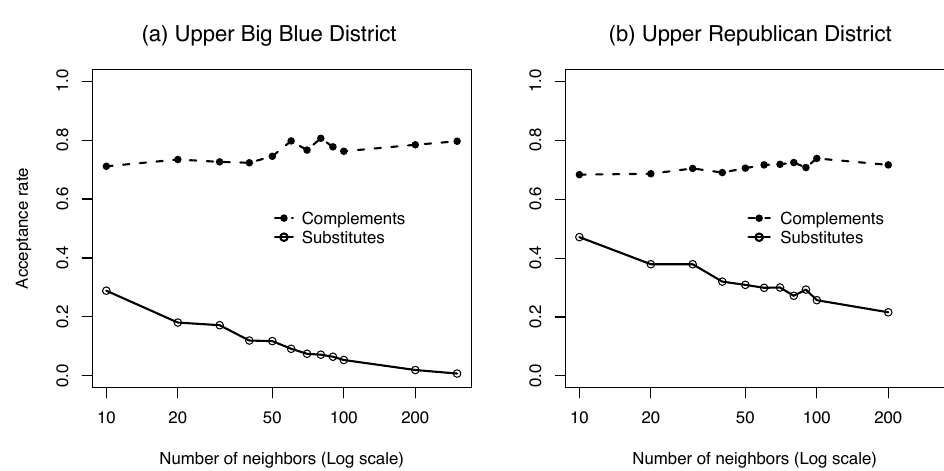
Figure 2. Acceptance rate of the GW program with strategic substitutes/complements as a function of N